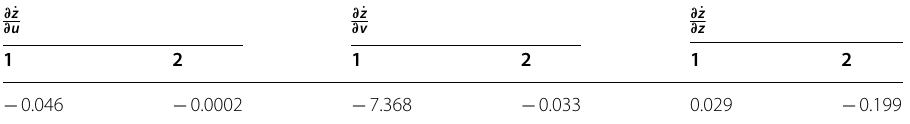
0.6745 (2) critical =